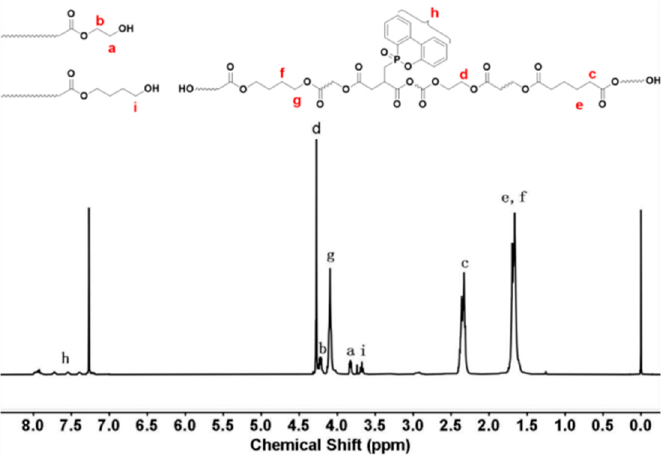
Figure 1. 1 H NMR spectrum of PPE.